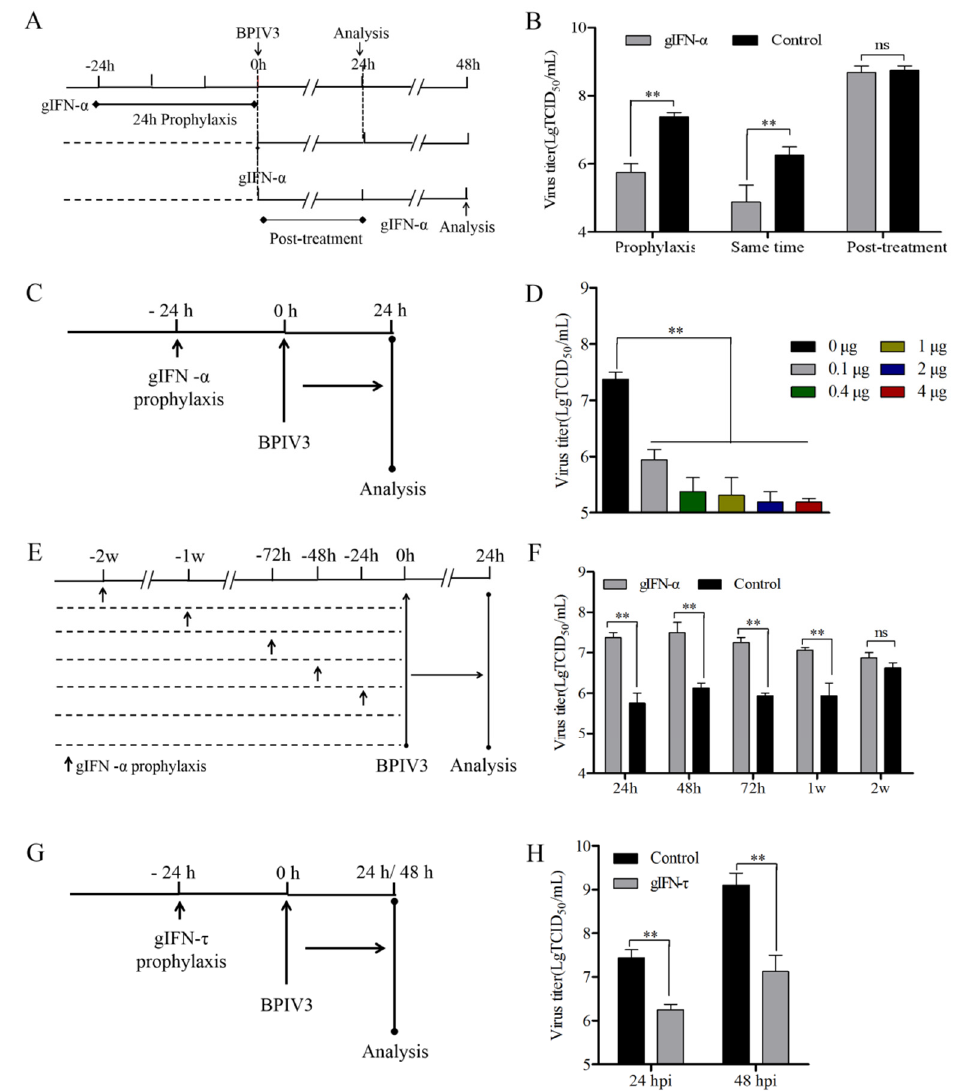
Figure 6. Exogenous goat IFN- α and IFN- τ inhibit BPIV3 replication in MDBK cells. ( A , C , E , G ) Experimental schematic. ( A ) MDBK cells were treated with goat IFN- α (1 µ g/mL) 24 h before infection or together with infection, and then the samples were harvested at 24 hpi. MDBK cells were treated with goat IFN- α (1 µ g/mL) 24 h after infection, and the samples were harvested 24 h later. The viral titer in untreated cells was used as the negative control. ( C ) MDBK cells were treated with different concentrations of goat IFN- α (0, 0.1, 0.4, 1, 2, or 4 µ g/mL) 24 h before infection, and the samples were harvested at 24 hpi. ( E ) MDBK cells were pretreated with goat IFN- α (1 µ g/mL), cells were subsequently cultured for varying lengths of time (24 h, 48 h, 72 h, 1 w, or 2 w) prior to infection, and harvested at 24 hpi. ( G ) MDBK cells were pretreated with goat IFN- τ (0 or 1 µ g/mL) 24 h before infection, and the samples were harvested at 24 hpi and 48 hpi. ( B , D , F , H ) TCID 50 results. the virus titers in the culture supernatant between different groups were detected, as shown in the corresponding schematic. The untreated cells were used as the negative control. MDBK cells were infected with BPIV3 at an MOI of 1. The results were reported based on duplicate independent experiments and compared with the negative control in each group. *, p < 0.05, **, p < 0.01.